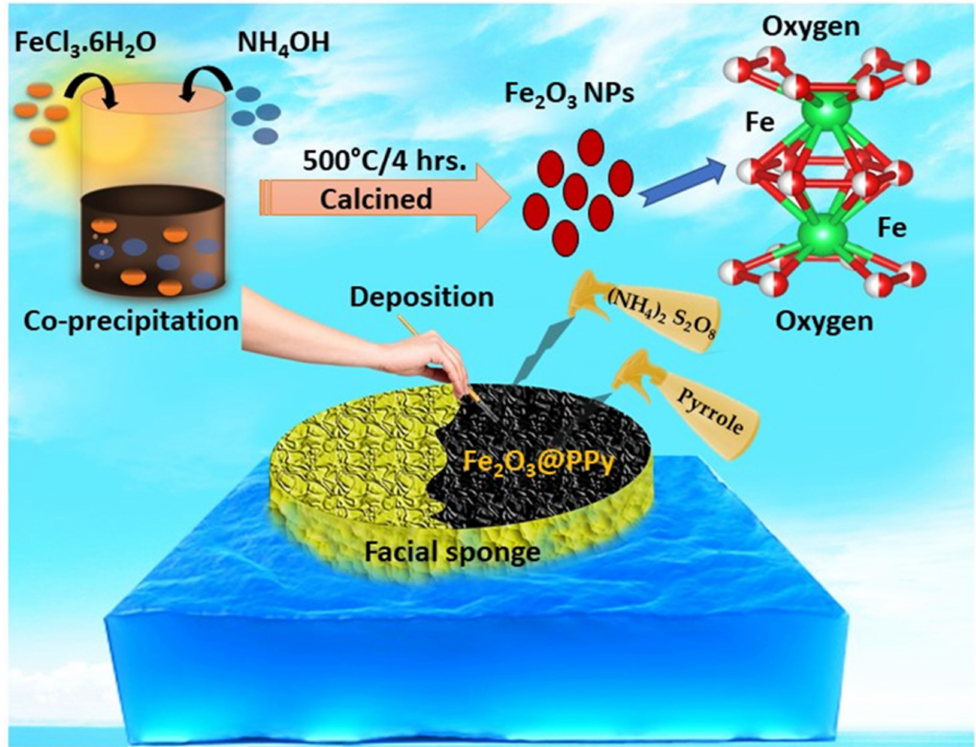
Figure 1. Schematic demonstration of the synthesis of Fe 2 O 3 NPs, deposition of Fe 2 O 3 NPs over the two-dimensional facial sponge, and it’s in situ polymerization of Fe 2 O 3 @PPy interfacial solar steam